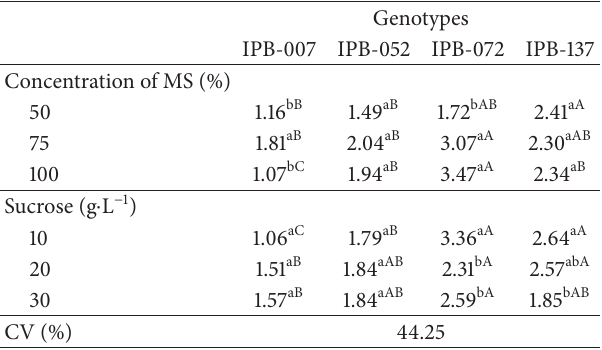
Table 5: Coloration of sweet potato plant shoots after 180 days of in vitro conservation under 18 ∘ C, depending on the genotype and variations in the concentration of MS salts and sucrose.